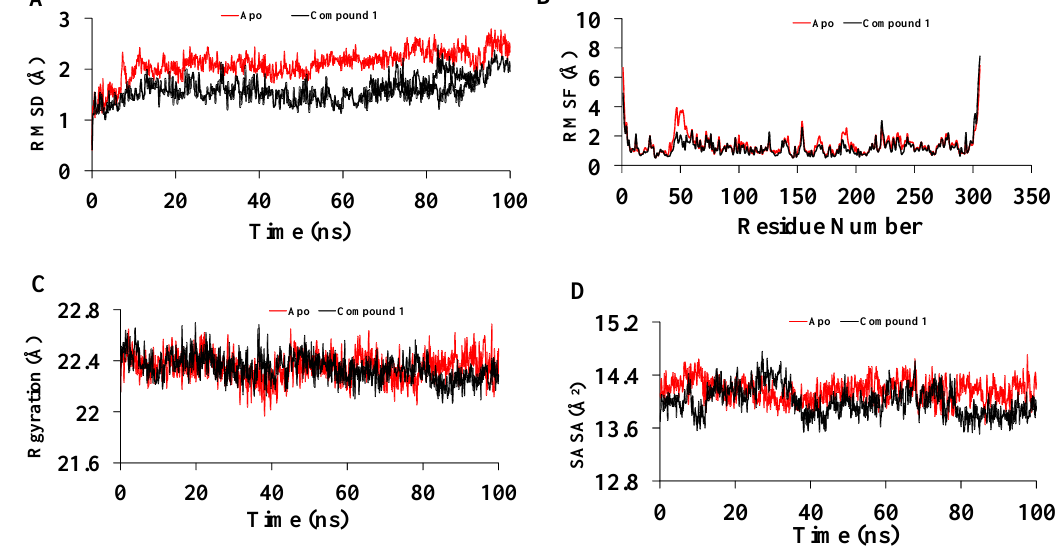
Figure 6. ( A ) Root means square deviation values of C- α atom of Mpro in the complexes with com- pound 1 and apo form along the 100 ns MD simulations. The structural changes of Mpro by means of ( B ) root means square fluctuations, ( C ) solvent accessible surface area, and ( D ) radius of gyration formed during the simulation.